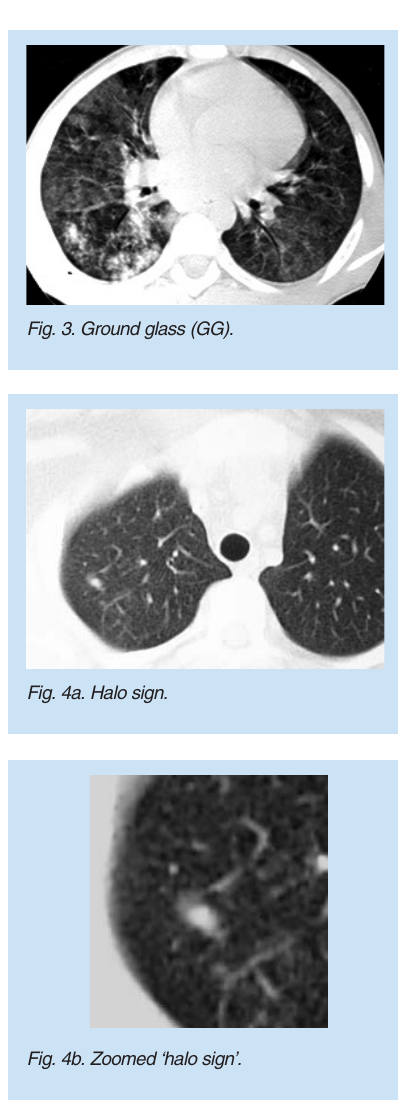
Fig. 4b. Zoomed ‘halo sign’.